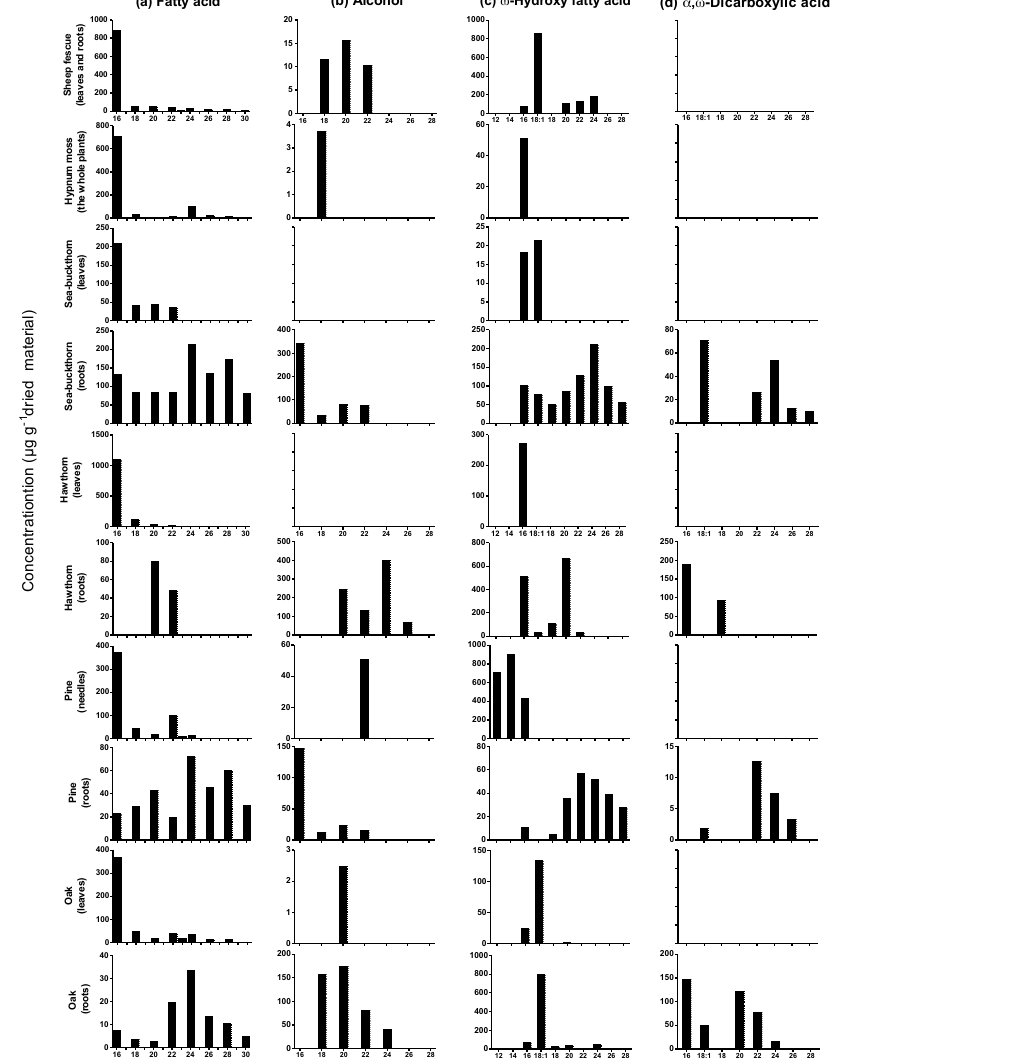
Figure 2. Chain length distribution of ester-bound lipids (µgg − 1 dried material) upon BF 3 –MeOH hydrolysis of vegetation leaves and roots. (a) fatty acids; (b) alcohols; (c) ω -hydroxy fatty acids; (d) α , ω -dicarboxylic acids.